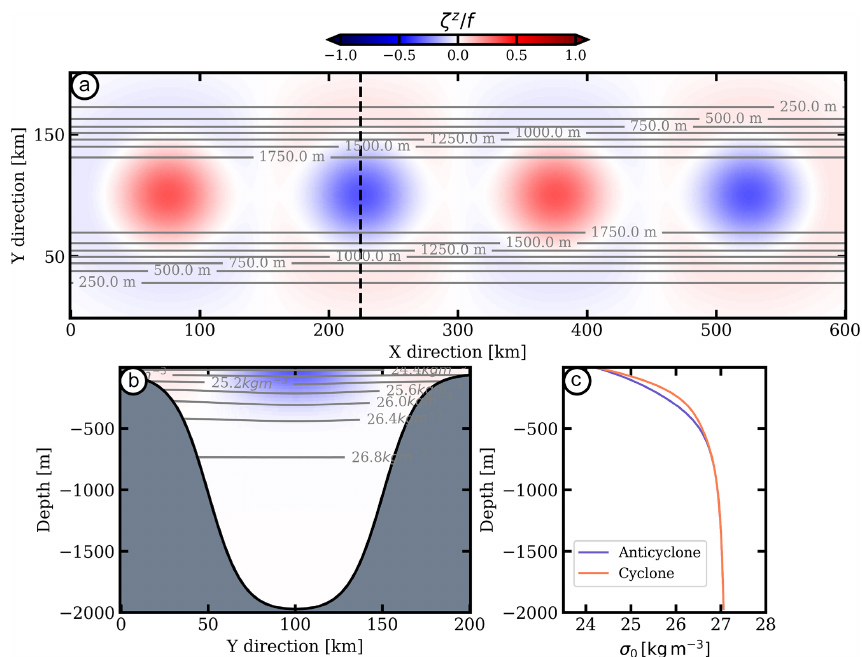
Figure 1. Initial state: (a) vertical relative vorticity (normalized by the Coriolis frequency) for the four surface-intensified mesoscale eddies. Black contours are the isobaths. (b) Vertical cross section of an anticyclone. (c) Vertical profiles of density associated with the cores of a mesoscale cyclone (orange) and of an anticyclone (blue).